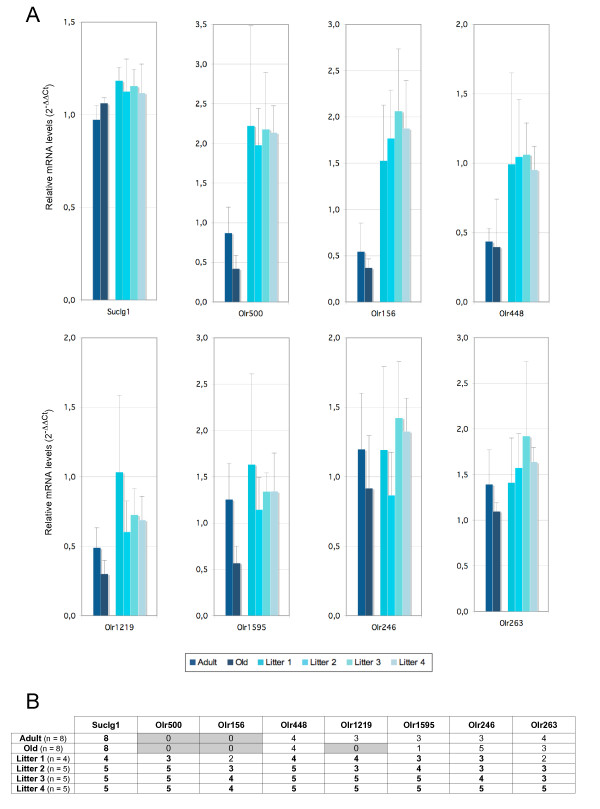
Expression levels of OR genes expressed at birth but not in older rats. (A) RNA samples prepared from olfactory epithelia (4 adults, 4 old rats and 19 newborns from each litter L1 to L4) were used for RTqPCR of 7 OR genes identified by microarray analysis as expressed in newborns only. Each mRNA was analyzed in triplicate and a mean value calculated. ΔCt values were calculated with respect to the Hprt values and ΔΔCt with respect to a control sample equated to 1. Further, the analyses were performed on four samples of the same group of age; error bars represent means ± SD (n = 4 rat RNA samples per group). (B) The table shows the number of samples giving a hybridization signal above background. For Olr500, taken as an example, none of the 8 adult and 8 old rat samples gave a hybridization signal above background. Conversely, all samples from the 15 newborn rats from litters L2 to L4 and three newborn rats of the four of litter L1 gave a hybridization signal above background.